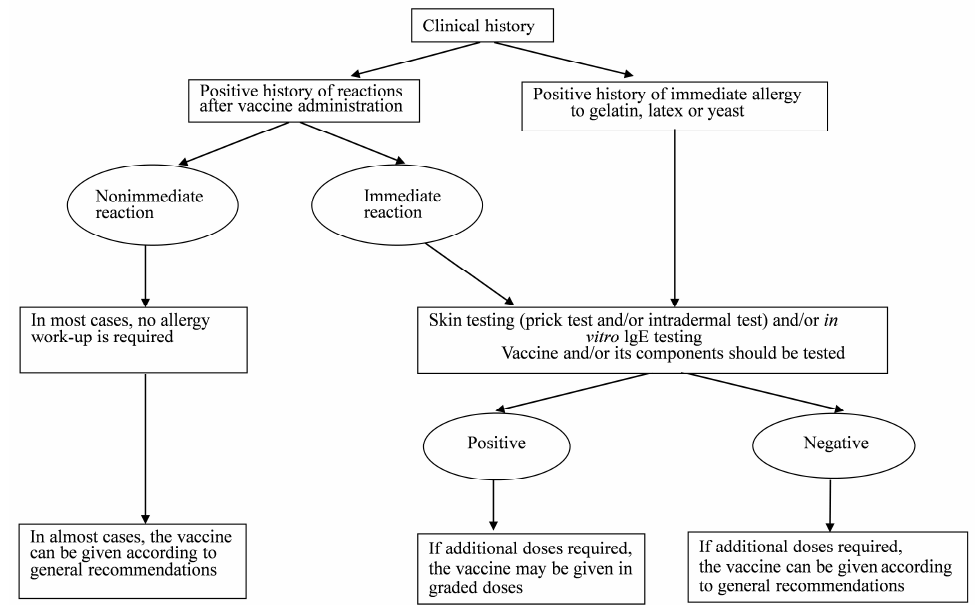
Figure 1. Management of children with suspected hypersensitivity to a vaccine, and children with a known allergy to a vaccine component (modified from Dreskin, et al. 2016; reprinted/adapted with permission from Elsevier) [7].